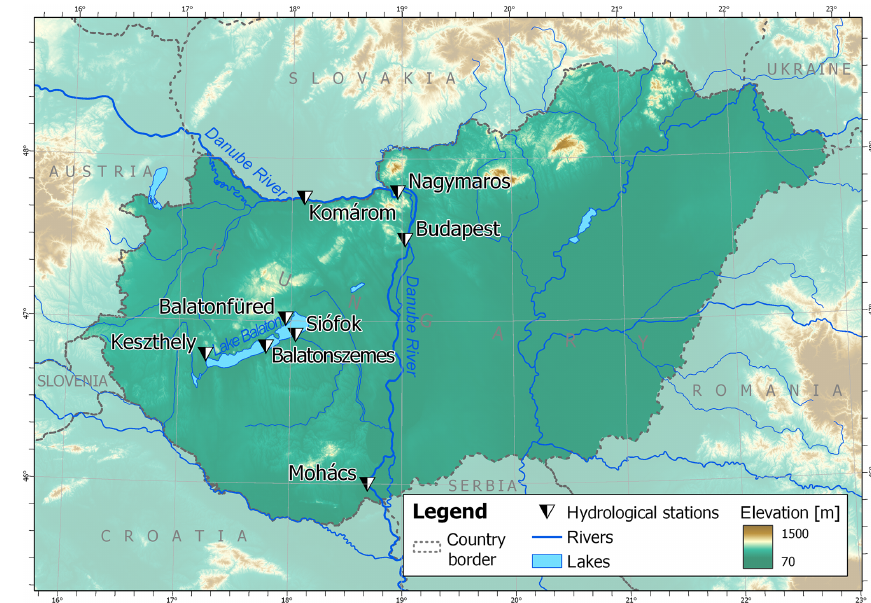
Figure 1. Locations of the hydrological stations mentioned in this study.